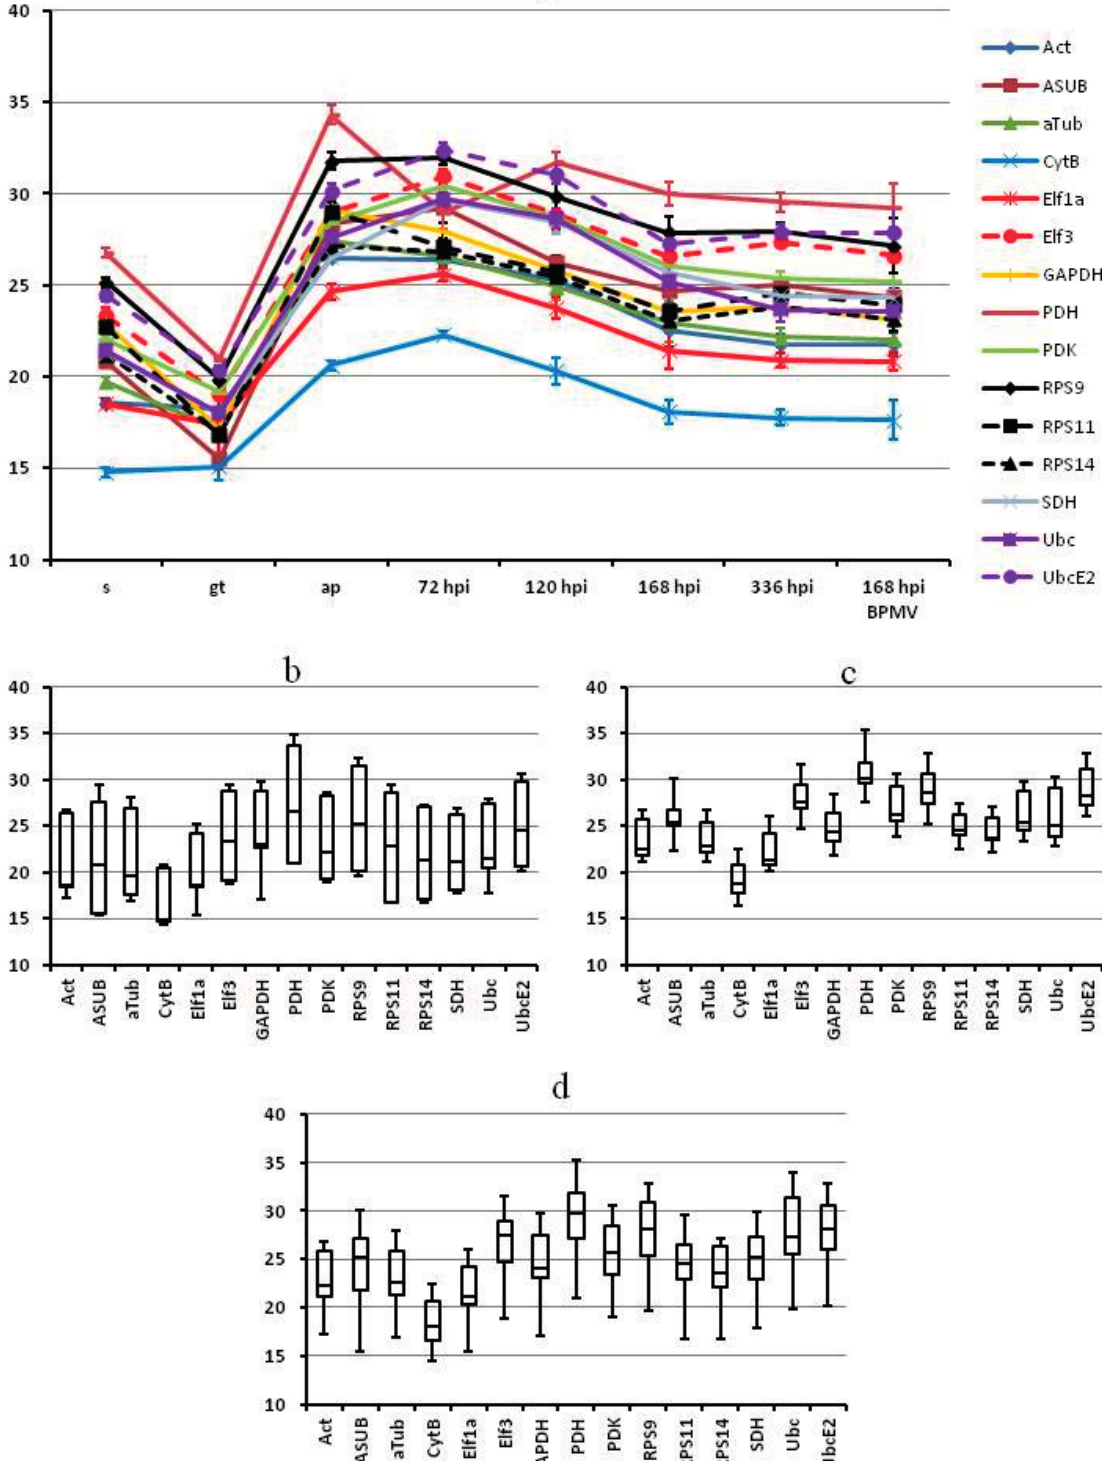
Figure 1. Variation of C q values for P. pachyrhizi candidate reference genes between samples (vertical axis: C q). ( a ) Average and standard deviation of C q values for every sample; ( b – d ) box plots representing the range of C q values; ( b ) in vitro samples; ( c ) in planta samples; ( d ) all samples. For better representation of RNA abundance the C q values were corrected for primer efficiency: C q corr = lg 2 ((2 × e) C q